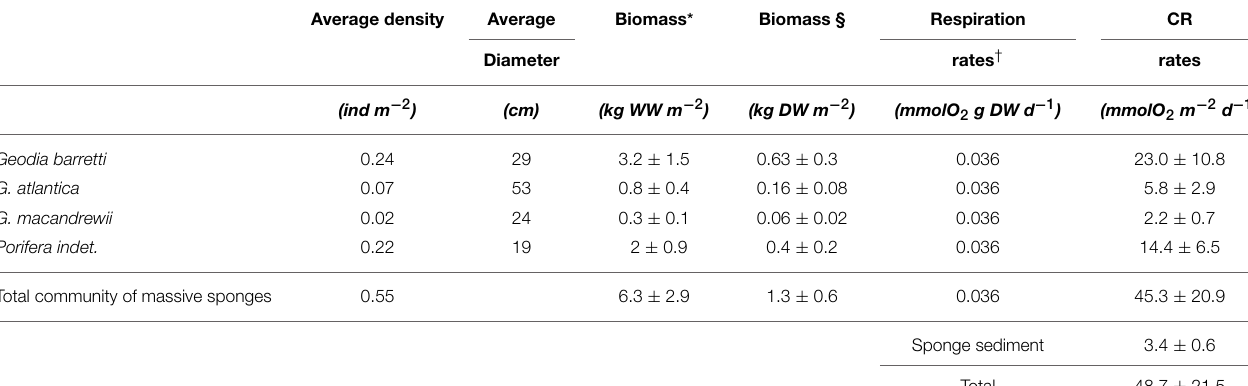
TABLE 3 | Estimation of the sponge density and biomass from ROV video survey images and of respiration rates.